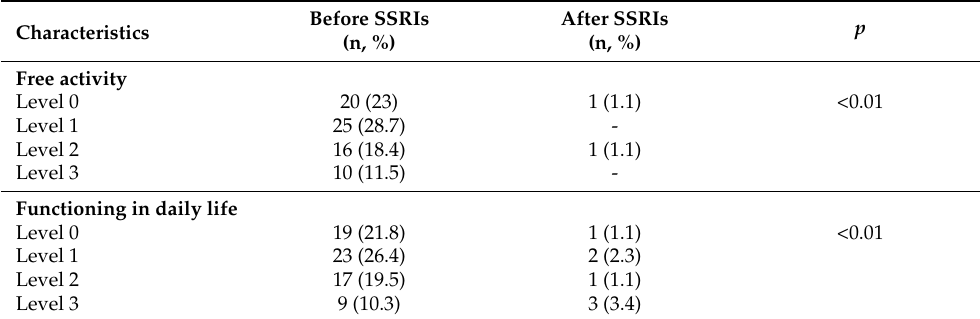
Table A2. Characteristics of physical functioning (bad) according to mMRC before and after the use of SSRIs.